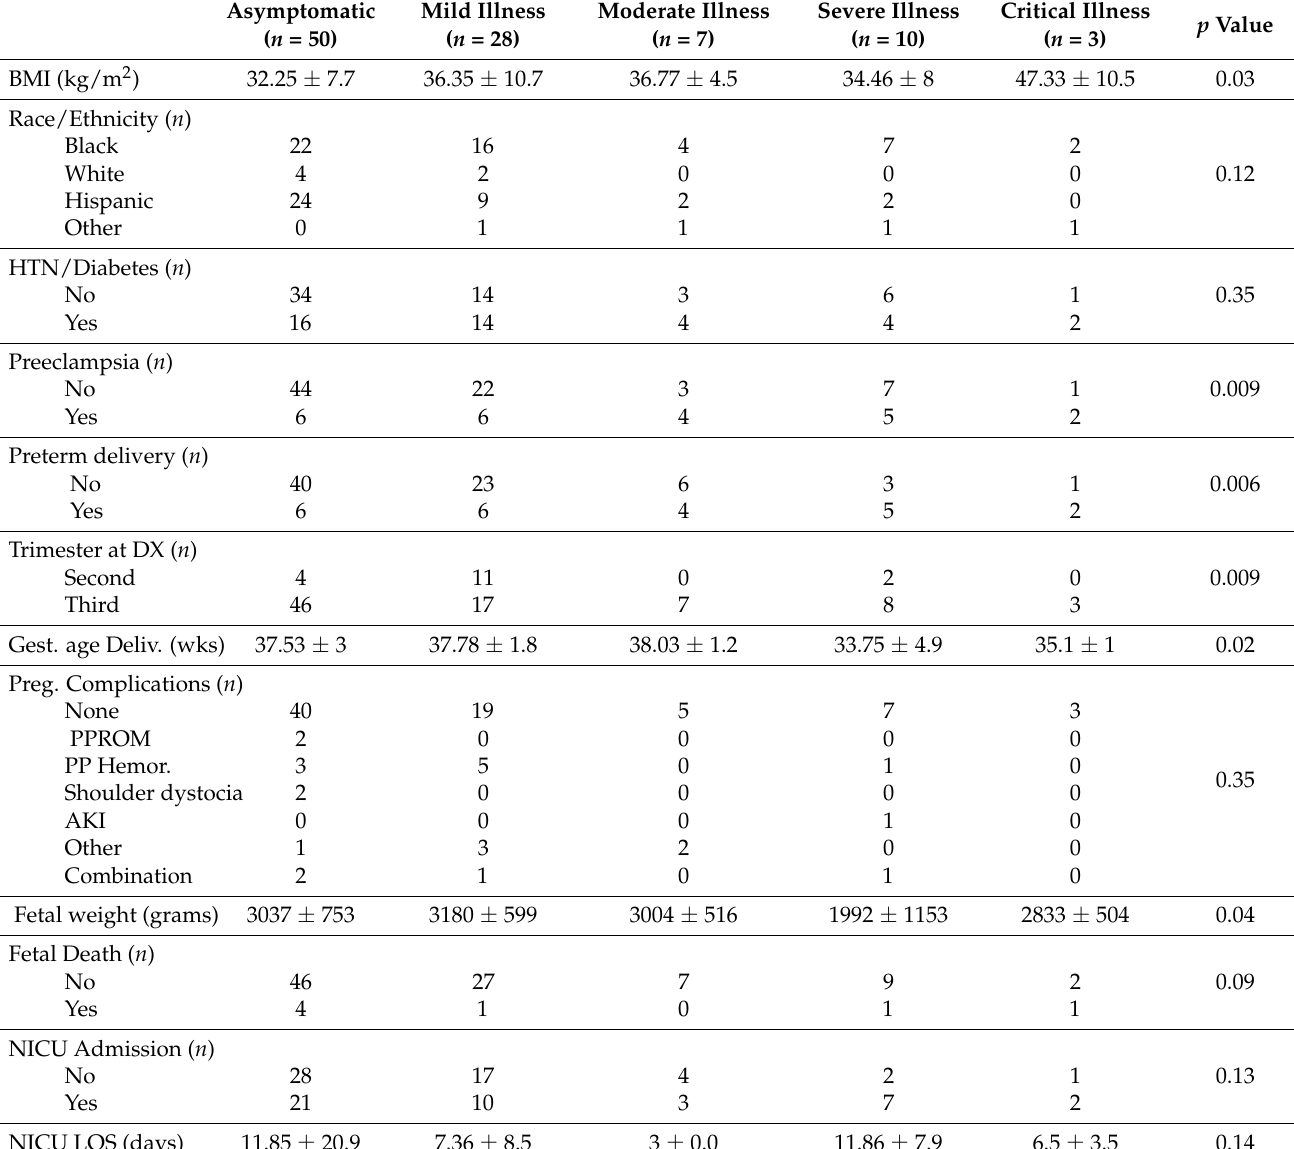
Table 1. Patient characteristics based on severity of COVID-19.